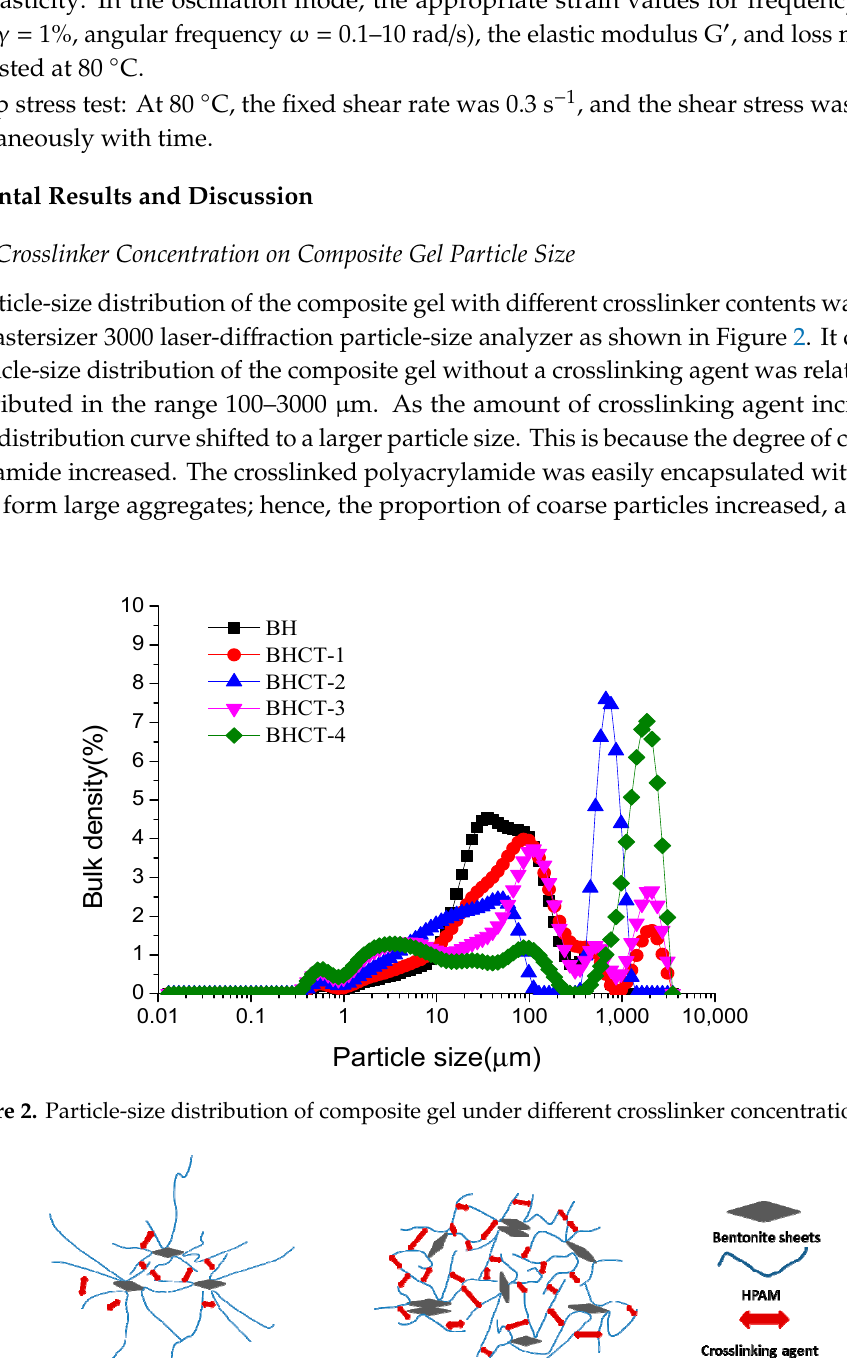
Figure 3. Schematic of particle-size change of composite gel under di ff erent crosslinker